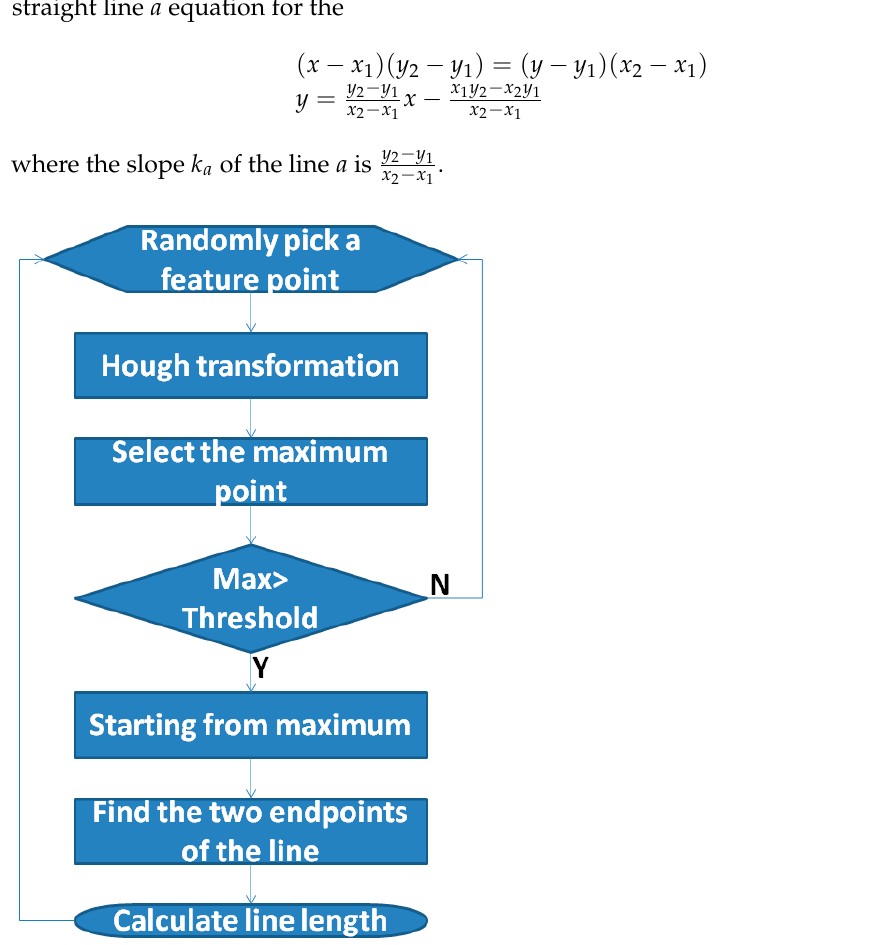
Figure 9. Progressive Probabilistic Hough Transform detects straight-line data.